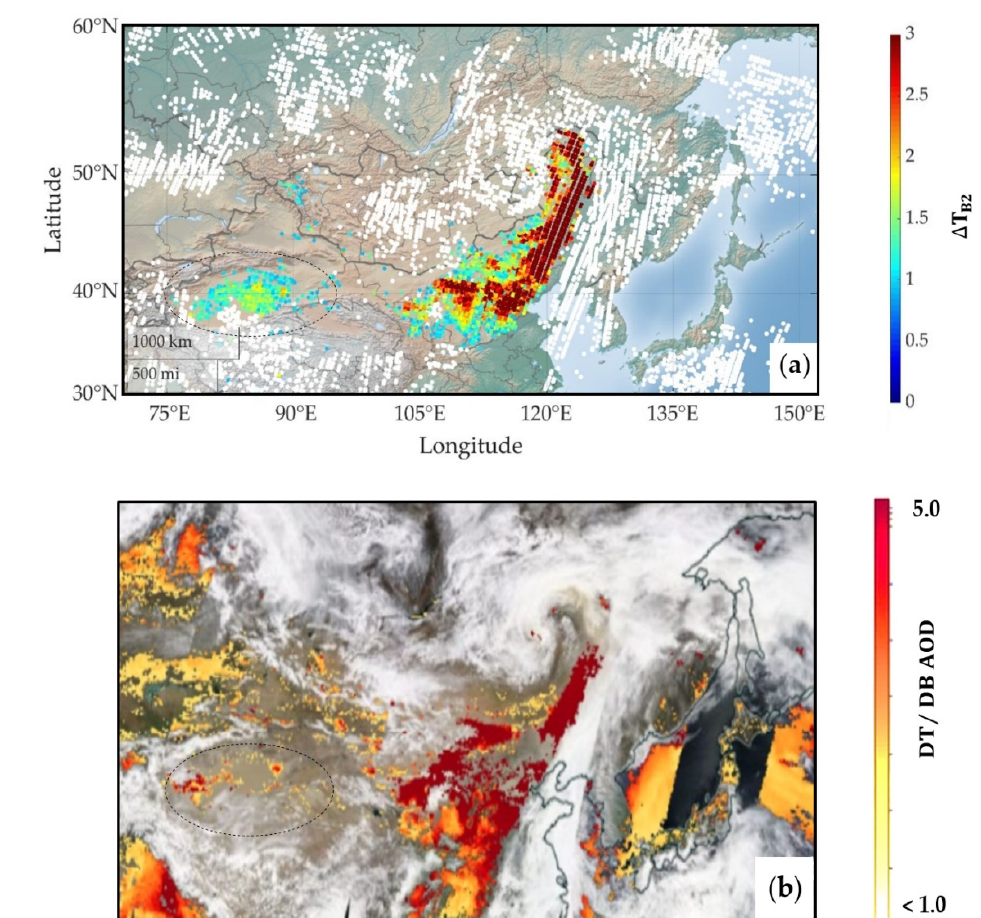
Figure 2. ( a ) Difference in the brightness temperature of the IASI dust selection during the dust storm on 4 May 2017, by day; ( b ) merged dark target/deep blue aerosol optical depth from MODIS/Terra on 4 May 2017 (https://worldview.earthdata.nasa.gov, accessed on 1 December 2021). The dashed black circle region presents the false aerosol detection region.